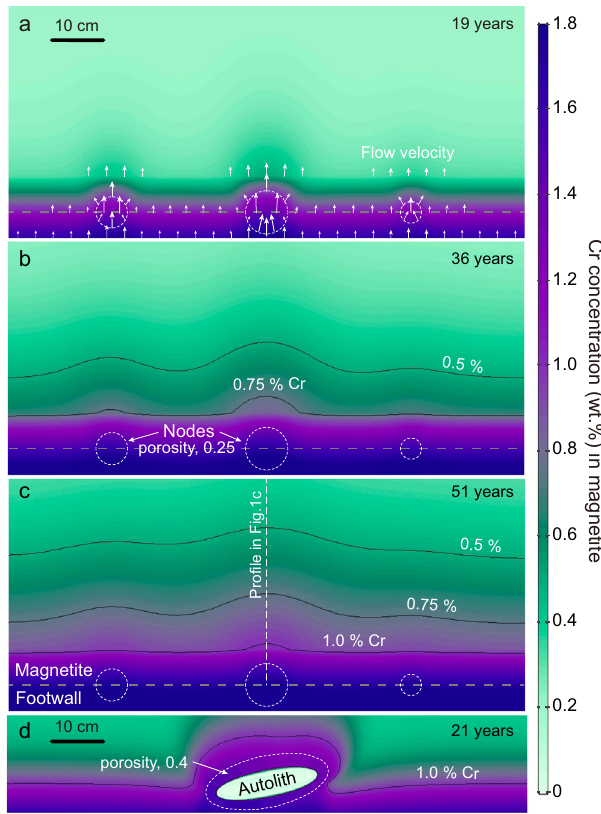
Fig. 3 Two-dimensional models of reactive transport of Cr in magnetite crystal mush. a – c Snapshots of modeled Cr compositional mapping for the percolation of basal magnetite mush with three high-porosity spheric nodes (0.25, white dashed lines). White arrows in a plot for melt fl ow vectors. d Cr contours drape over the anorthosite autolith due to its high-porosity contact zone (0.4, white dashed line) with magnetite mush. Black lines represent Cr